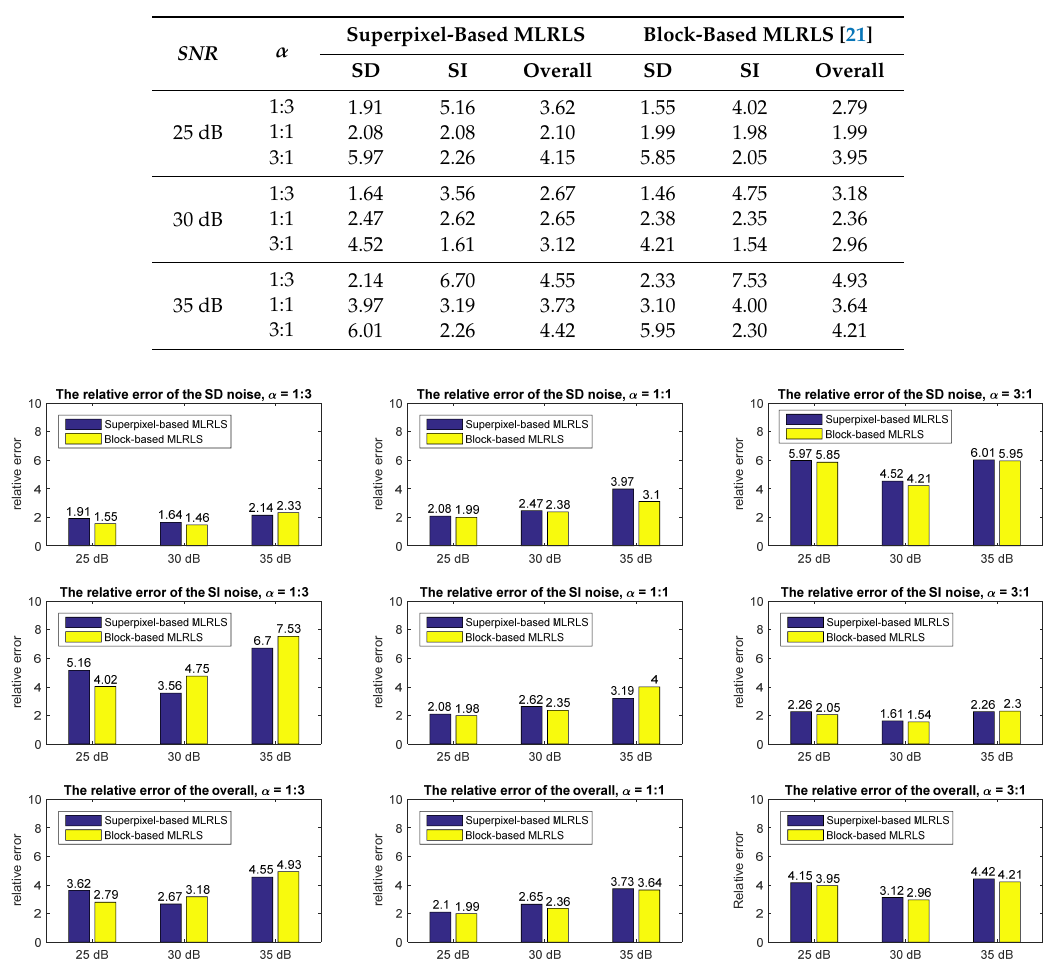
Table 8. The optimal relative errors of the SD noise, the SI noise and the overall optimization for the textured HSI.